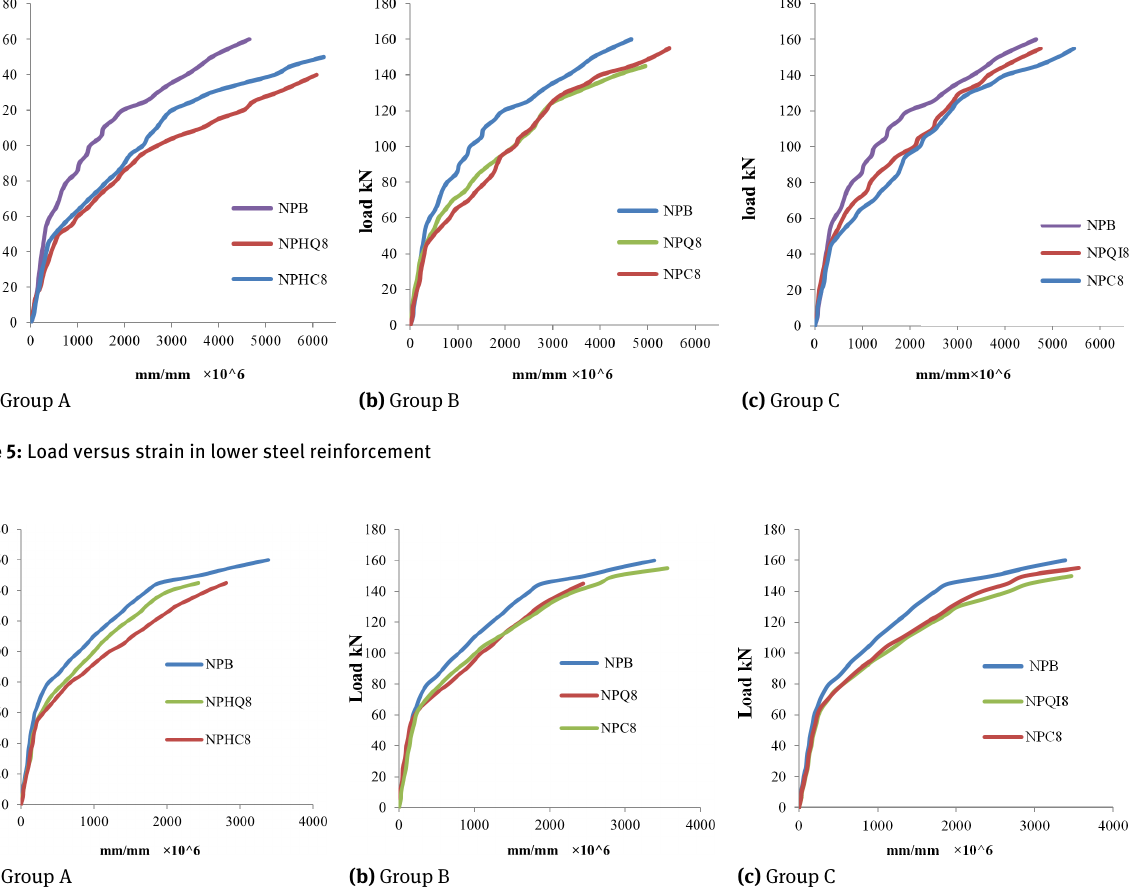
tensile test findings done on a 10 mm diameter bar. Thus, all beams passed over this limit at the failure stage. The